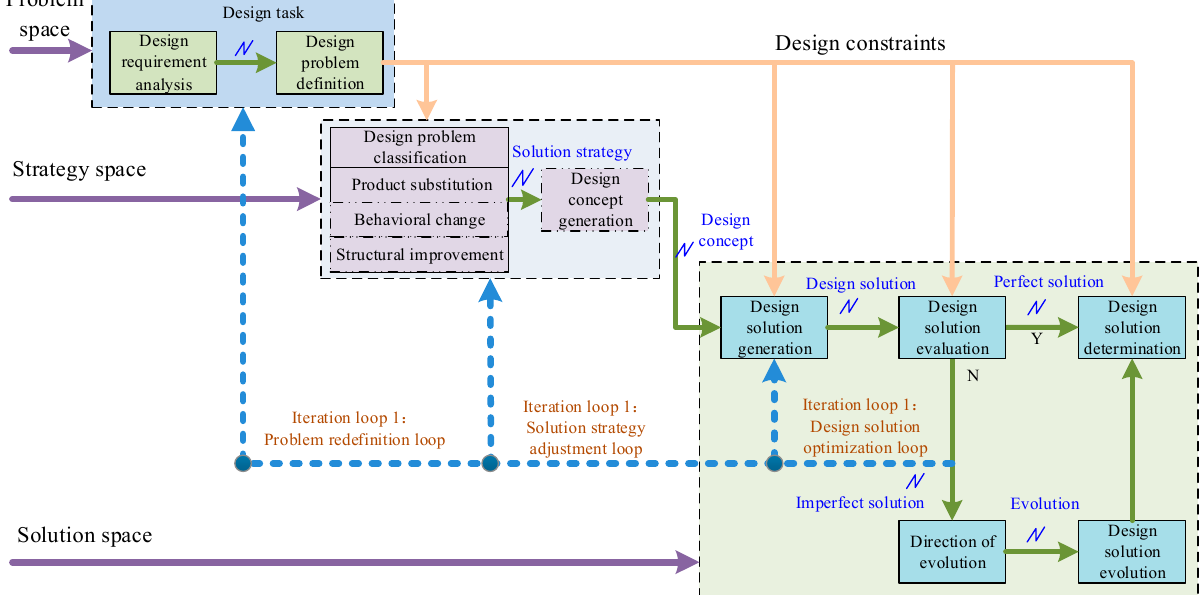
Figure 2. Solution evolution process model based on design iteration.